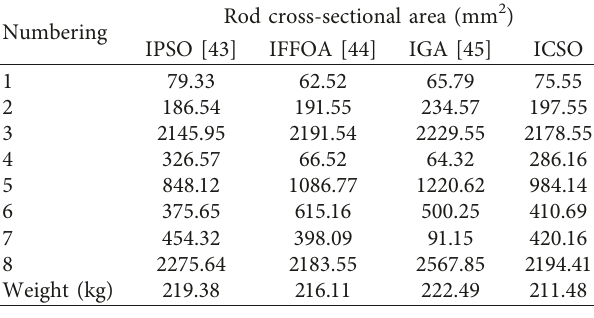
Table 6: Comparison of optimization results for 25bar space truss.